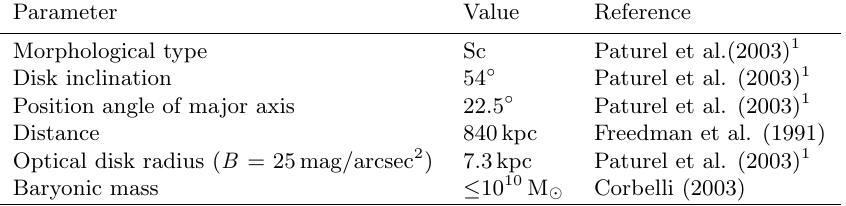
Table 2. The parameters of M